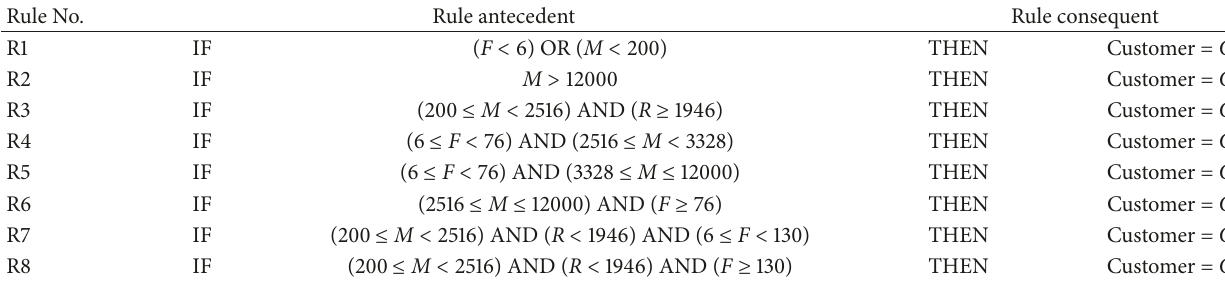
Table 5: Segmentation rules of ETC customers.